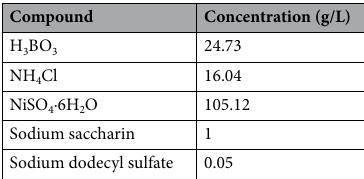
Table 1. Composition and concentration of electrodeposition